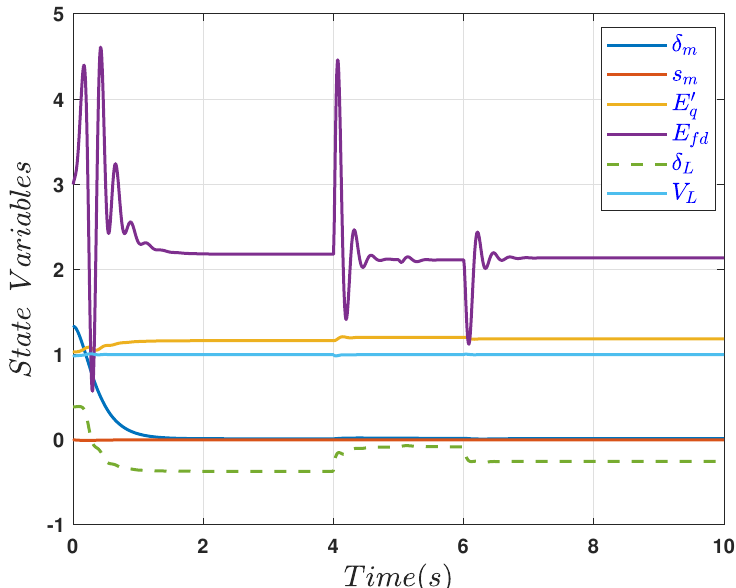
Figure 7. Controlled system (12) state variables time series with control in action at t = 0 ( s ) and load power